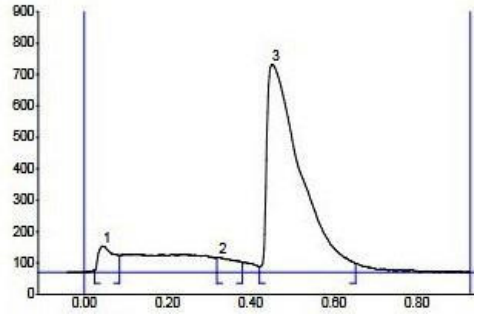
Fig. 13. 3D display of HPTLC chromatogram of M. cymbalaria fruit extracts and standards